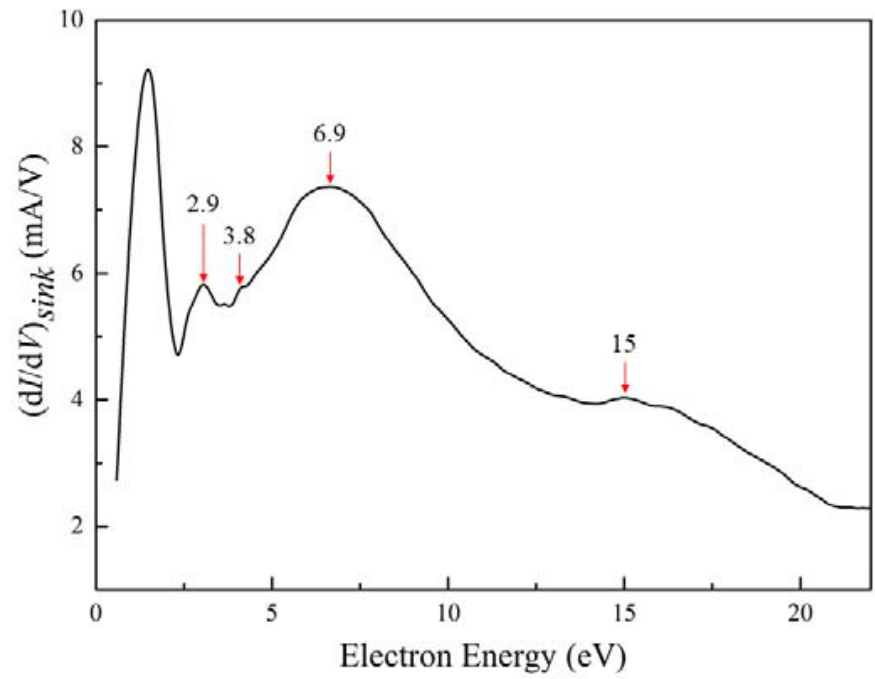
Figure 5. The first derivative modified by sink parameters for CH 4 –containing mixtures at atmo- spheric pressure with a flow rate of 5 mL/min and the discharge current of 10.7 mA, where 2.9, 3.8, 6.9 and 15 eV are the characteristic electronic peaks of O, CH, CH 4 and He, respectively. Due to the collisions of metastable helium with each other, high-energy electrons ( e * ) have an “electron activation” effect on CH 4 and O 2 , which consists of the following dissociation reactions of CH 4 and O 2 [31]: